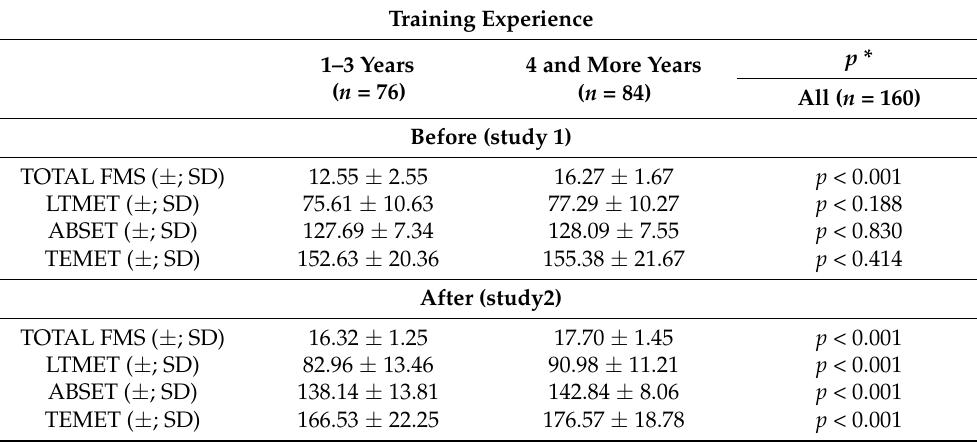
Table 6. The FMS composite score and core stability test results before and after the training program in groups of athletes with shorter and longer training experience. Training Experience p * 1–3 Years 4 and More Years ( n = 76) ( n = 84) All ( n = 160) Before (study 1) TOTAL FMS ( ± ; SD) 12.55 ± 2.55 16.27 ± 1.67 p < 0.001 LTMET ( ± ; SD) 75.61 ± 10.63 77.29 ± 10.27 p < 0.188